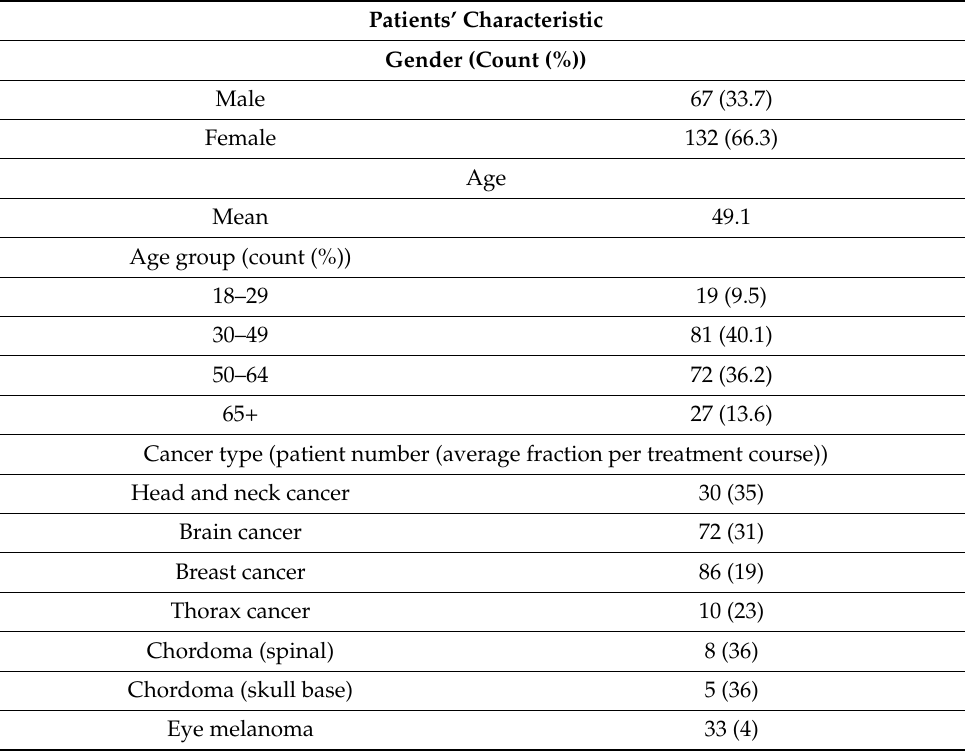
Table 1. Characteristic of the patient population at the PT